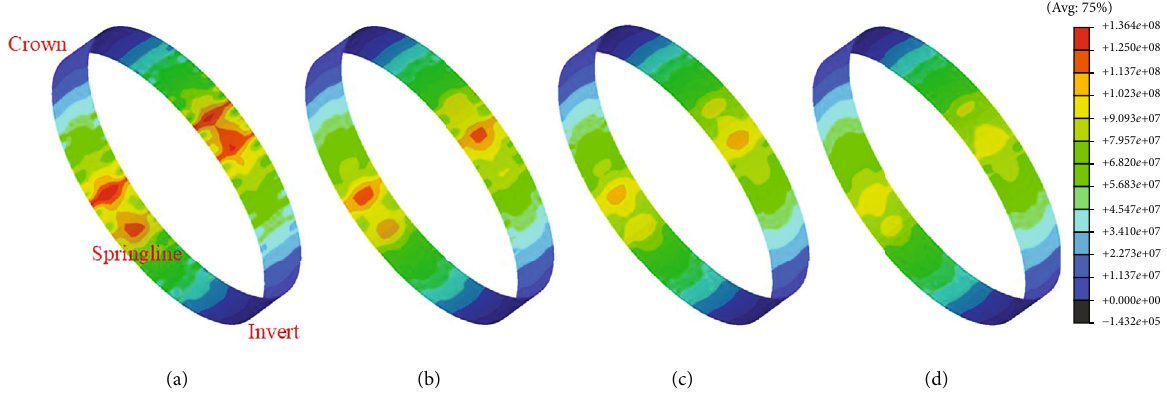
Figure 11: Stress maps of CFRP under combined loads: (a) P-t-2; (b) P-t-4; (c) P-t-6; (d) P-t-8.